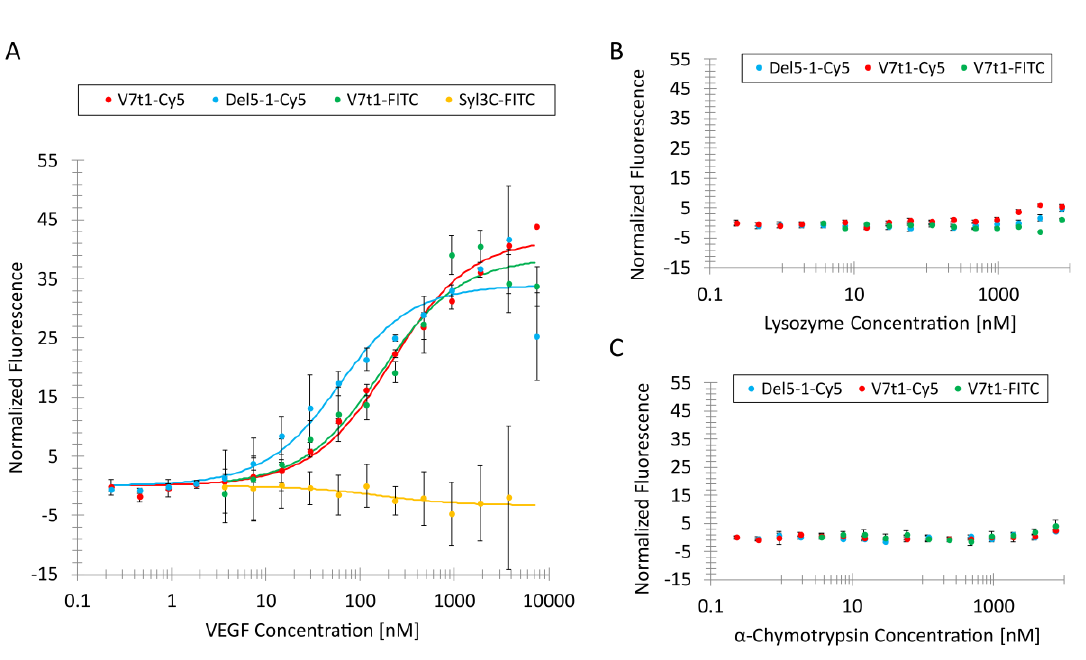
Figure 1. Binding curves for determining the dissociation constants (K D ) of the di ff erent fluorescently labeled aptamers towards ( A ) vascular endothelial growth factor (VEGF) and negative control proteins ( B ) lysozyme and ( C ) α